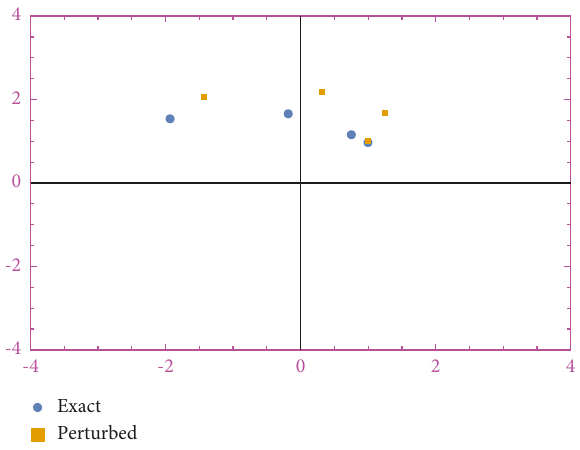
Figure 2: The plots of exact and perturbed